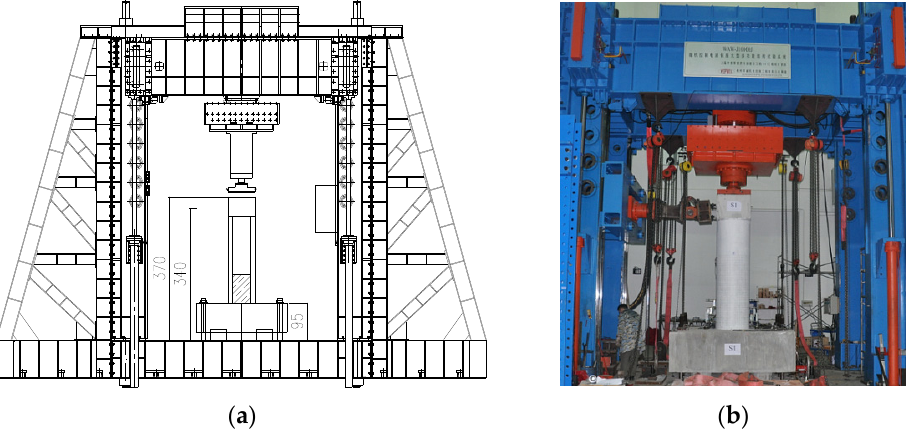
Figure 8. Loading device . ( a ) Loading schematic; ( b ) loading photo.